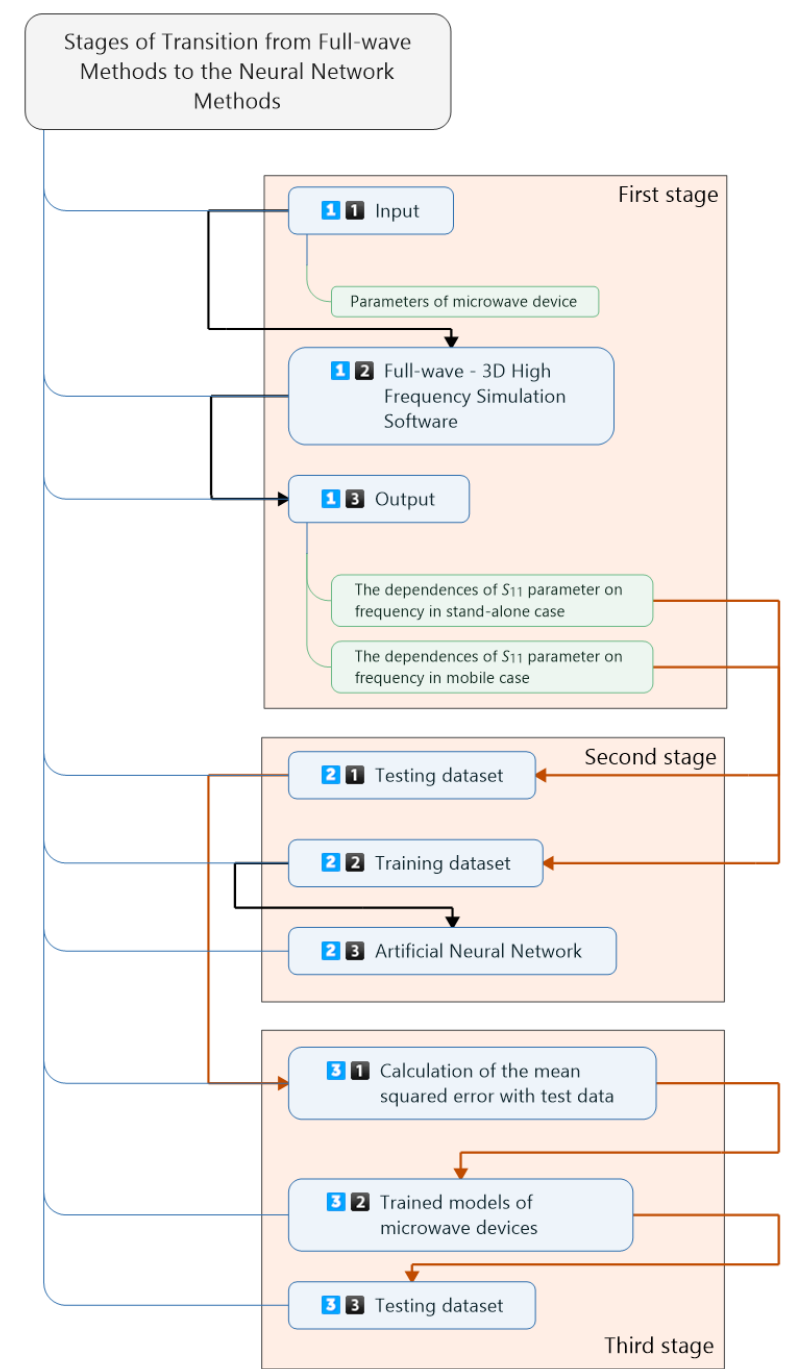
Figure 2. Stages of transition procedure of microwave devices modeling from calculations using the full-wave methods to the artificial neural networks based